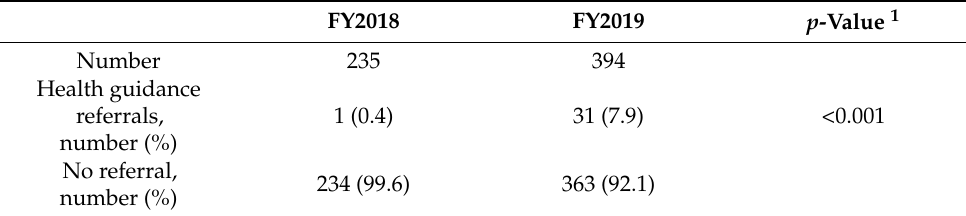
Table 4. Health guidance referrals for patients undergoing follow-ups at their own hospital. FY2018 FY2019 p -Value